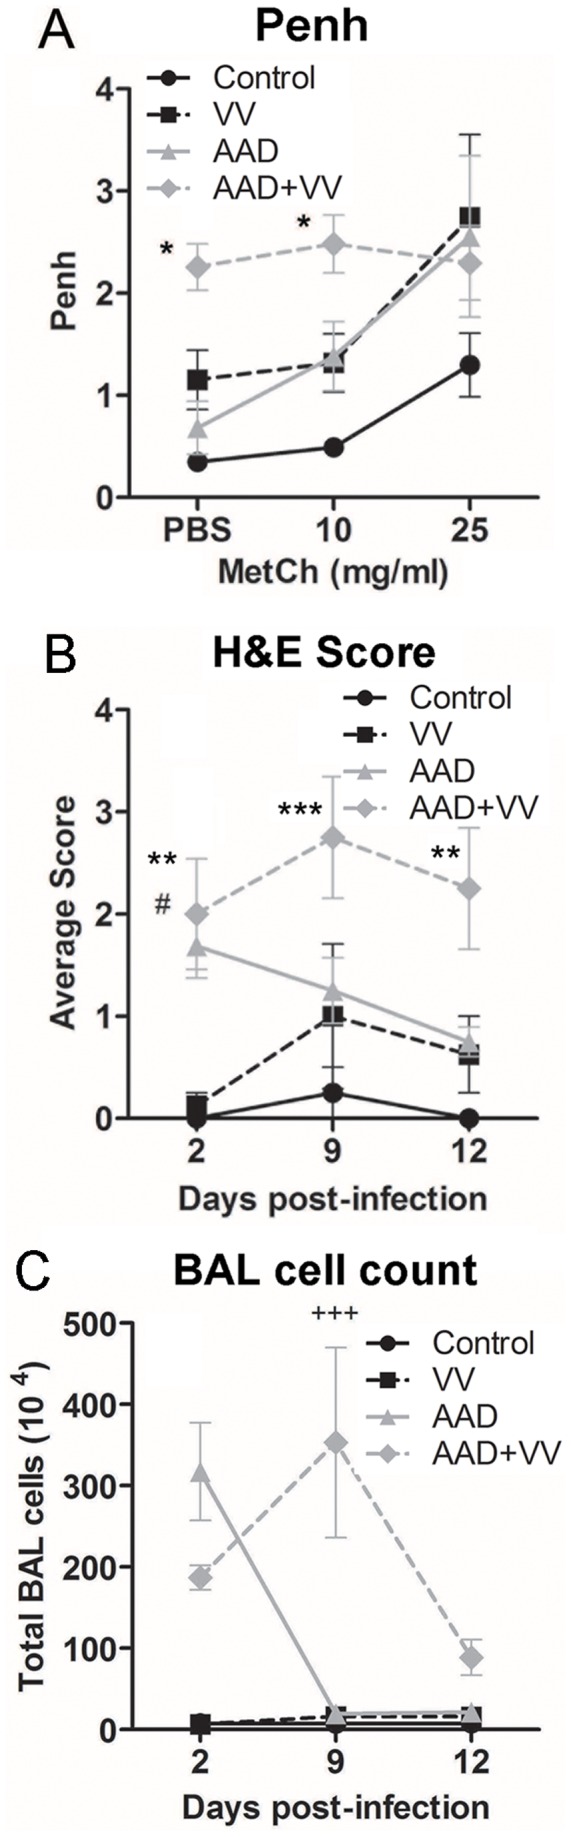
VV-infected AAD mice had increased signs of airway inflammation.(A) Non-invasive plethysmography was used to assess animal breathing. This analysis revealed increased responses to methacholine challenge (Penh) for control, VV and AAD mice at day 7 post-inoculation or mock treatment. In contrast, AAD mice inoculated with VV had elevated baseline Penh measurements suggesting an altered breathing pattern which was not sensitive to methacholine exposure. (B) Murine lung tissue was fixed in 10% formalin and paraffin-embedded sections were stained with H&E. Lung tissue inflammation was assessed by light microscopy and blindly scored using a semi-quantitative scale of 0–4, with a measure of 0 reflecting no inflammation, and 4 indicative of severe inflammation of peribronchiolar, periarterial and parenchymal spaces. AAD mice with or without VV infection had severe bronchiolar inflammation 2 dpi. VV-infected AAD mice had sustained inflammation through day 12 compared to AAD mice. (C) AAD mice with or without VV infection had elevated inflammatory cell infiltration in the BAL at 2 dpi. VV-infected mice with AAD had prolonged inflammatory cell infiltration in the BAL through 9 dpi. All values represented as mean ± SEM, 4–14 mice per group and representative of 3 independent experiments. Statistical significance was determined by a Two-way ANOVA with Bonferroni’s multiple comparisons test: *P<0.05, **P<0.01, ***P<0.001 AAD+VV vs. control; #
P<0.05, AAD+VV vs. VV. +++
P<0.001 AAD+VV vs. AAD.